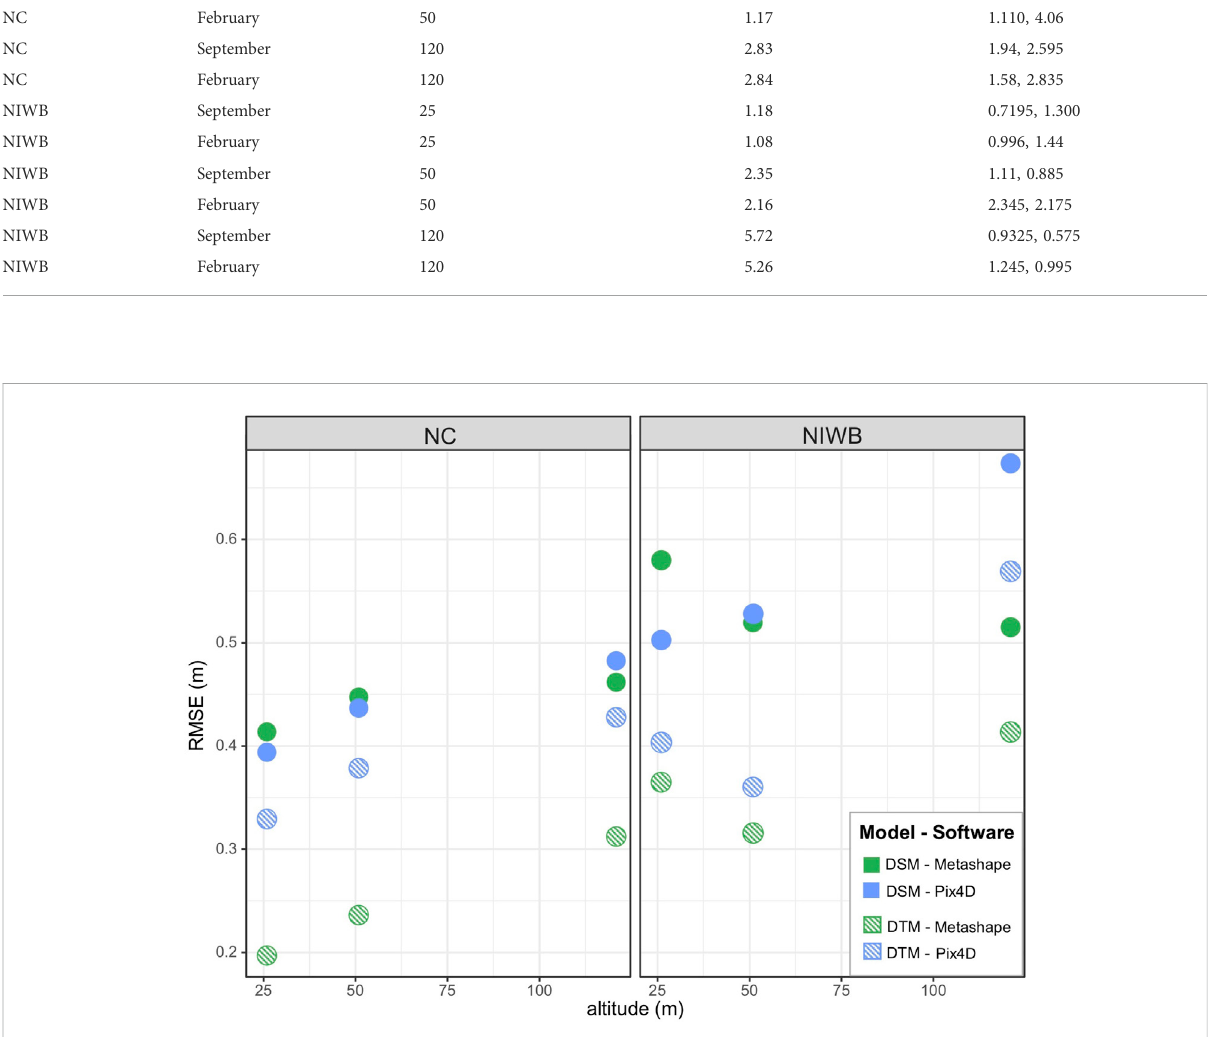
FIGURE 3 Verticalerrorappearedtodifferacrossmodelsandaltitudes.VerticalerrorwascalculatedasthedifferencebetweenGNSS-recordedelevations andSfM-computedmodelelevationatsitecheckpoints.Checkpointsrecorded duringbothSeptember (n=46,NC,n=64,NIWB)andFebruary(n= 56, NC, n = 42, NIWB) were included in the